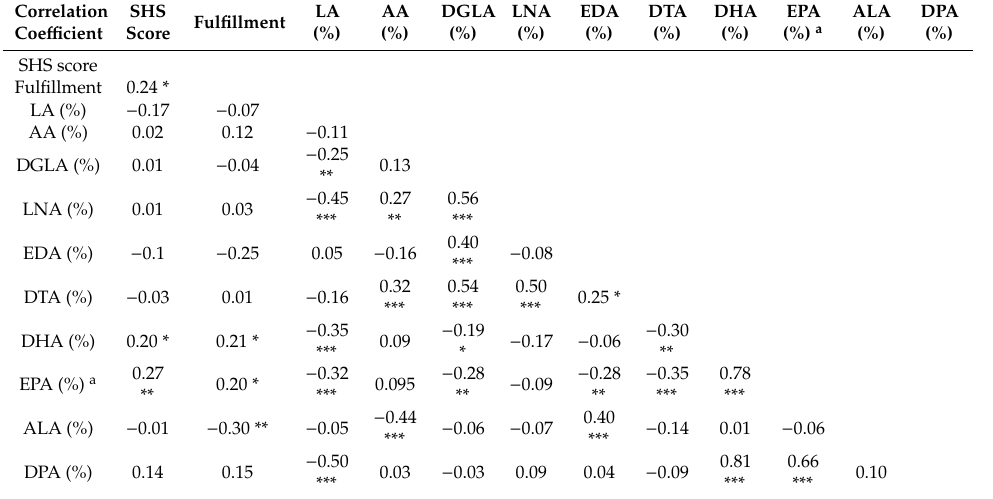
Table 2. Partial correlations between psychological indices and significant serum PUFA